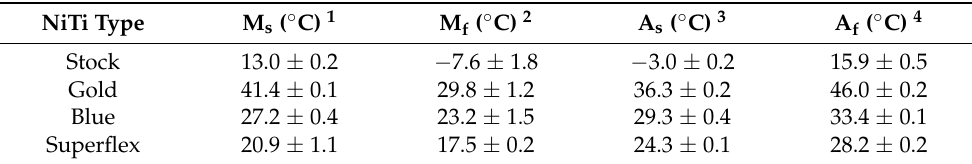
Figure 8. DSC curves for Stock, Gold, Blue and Superflex wires, indicating heat flow (mW) during cooling (upper trace) and heating (lower trace). Table 5. Transformation temperatures for NiTi wire samples. Data show means ± standard deviation for N = 3 samples for each